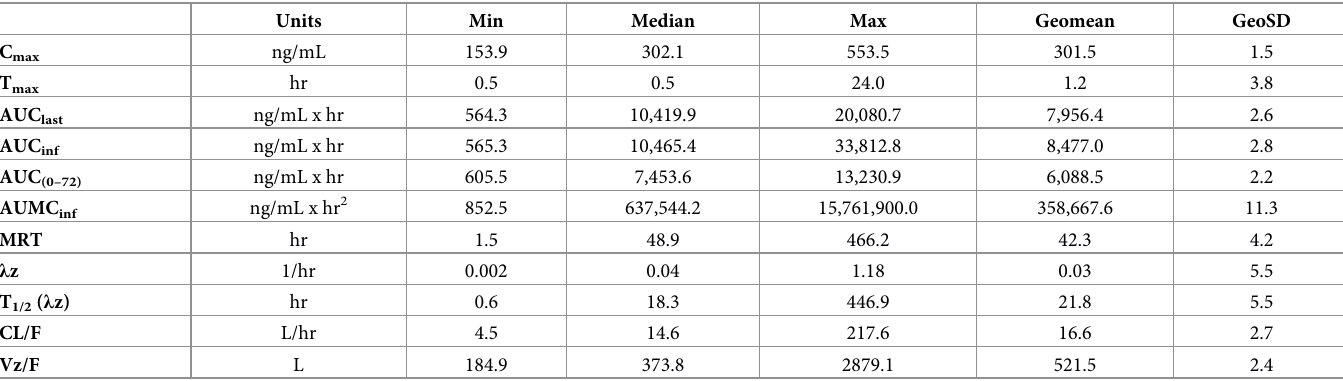
Table 2. Summary results from the non-compartmental analysis (NCA) of plasma tulathromycin data in 12 pregnant ewes challenged with Campylobacter jejuni .